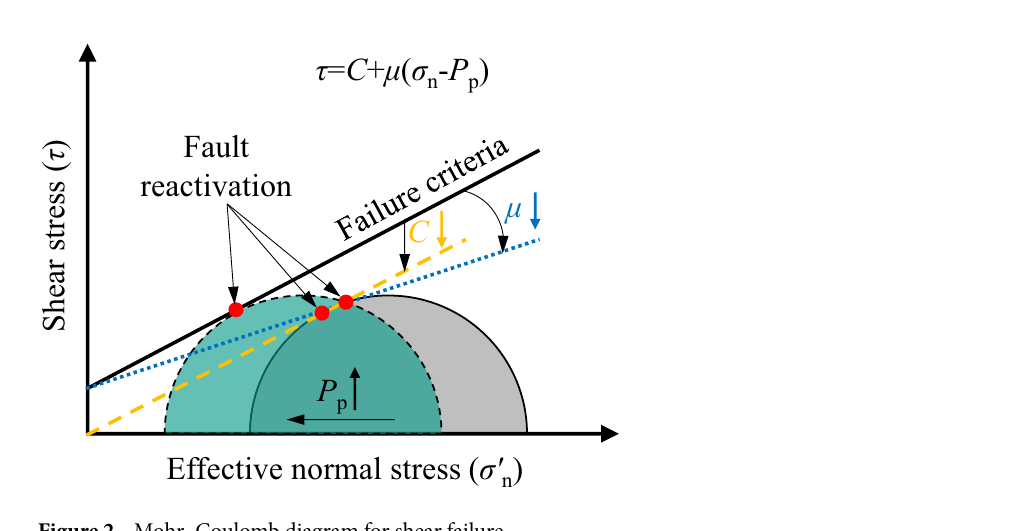
Figure 1. Schematic diagram of mechanisms for inducing earthquakes. An earthquake may be induced by increasing the fluid pressure acting on a fault (left) or by changing the shear and normal stress acting on the fault (right).